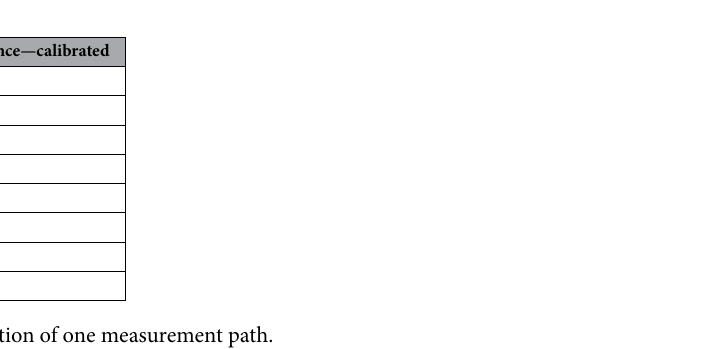
Table 1. Data from the calibration of one measurement path.